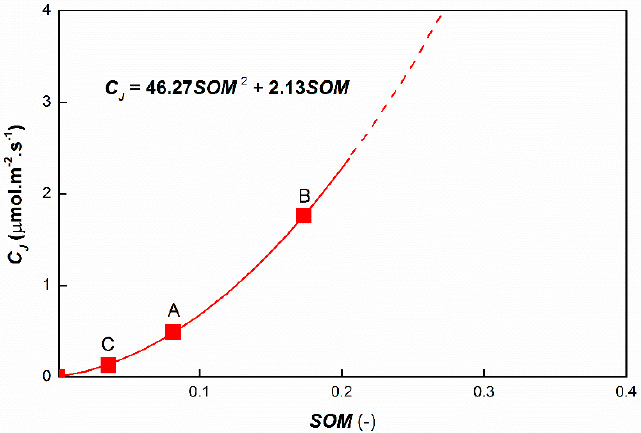
Figure 16. Correlation between C J and soil organic matter ( SOM ) at locations A, B, and C.